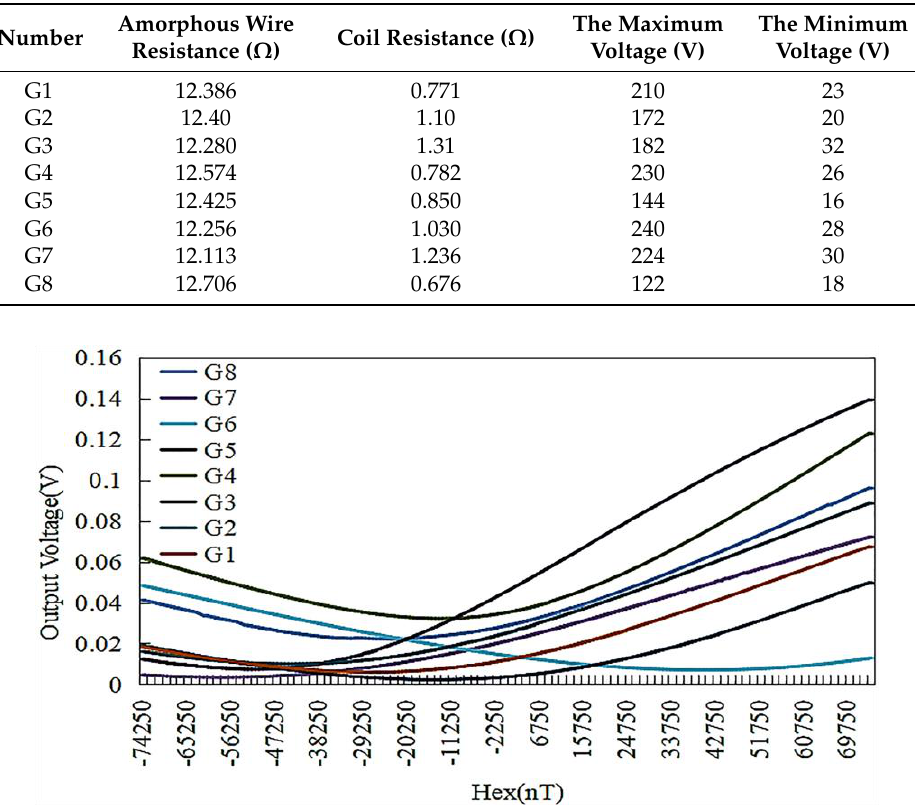
Figure 10. The consistency curve of the sensor output.